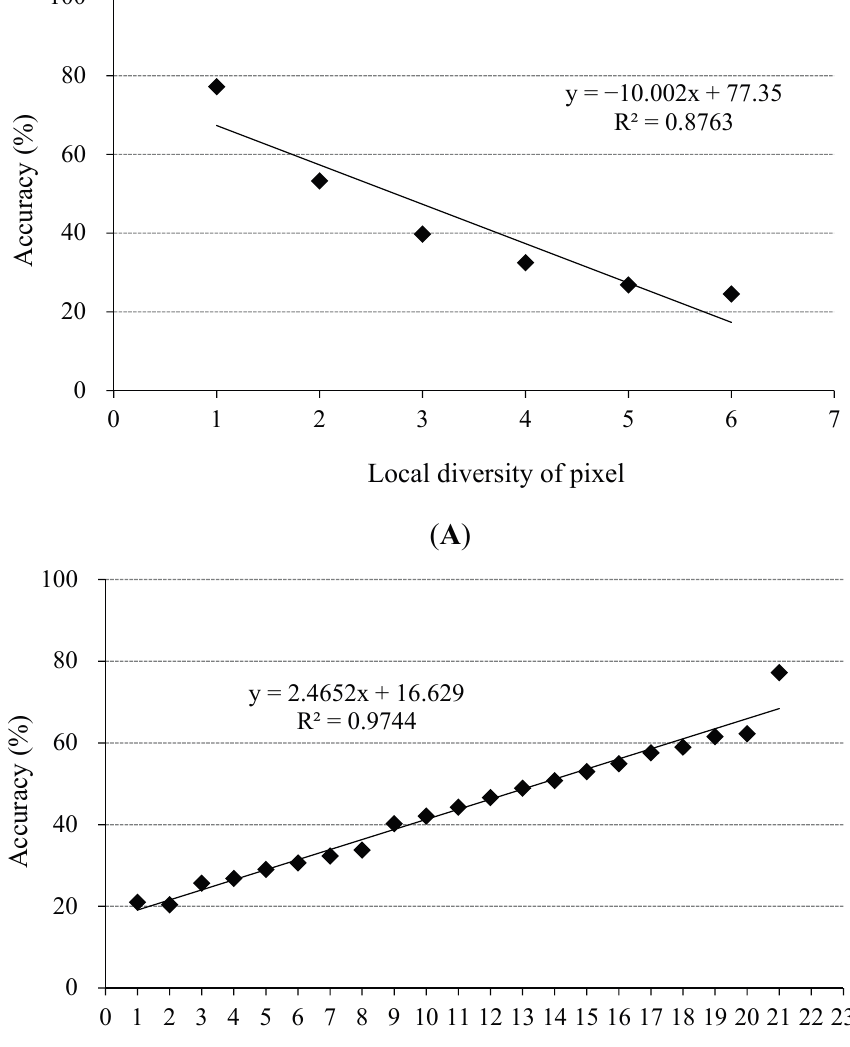
Figure 11. The relationships between the accuracy and pixel diversity and between the accuracy and the number of dominant pixels in the corresponding 100-m reference data (referred to as sub-pixels) within the extent of a classification pixel. ( A ) Relationship between the accuracy and pixel diversity. ( B ) Relationship between the accuracy and percentage of dominant